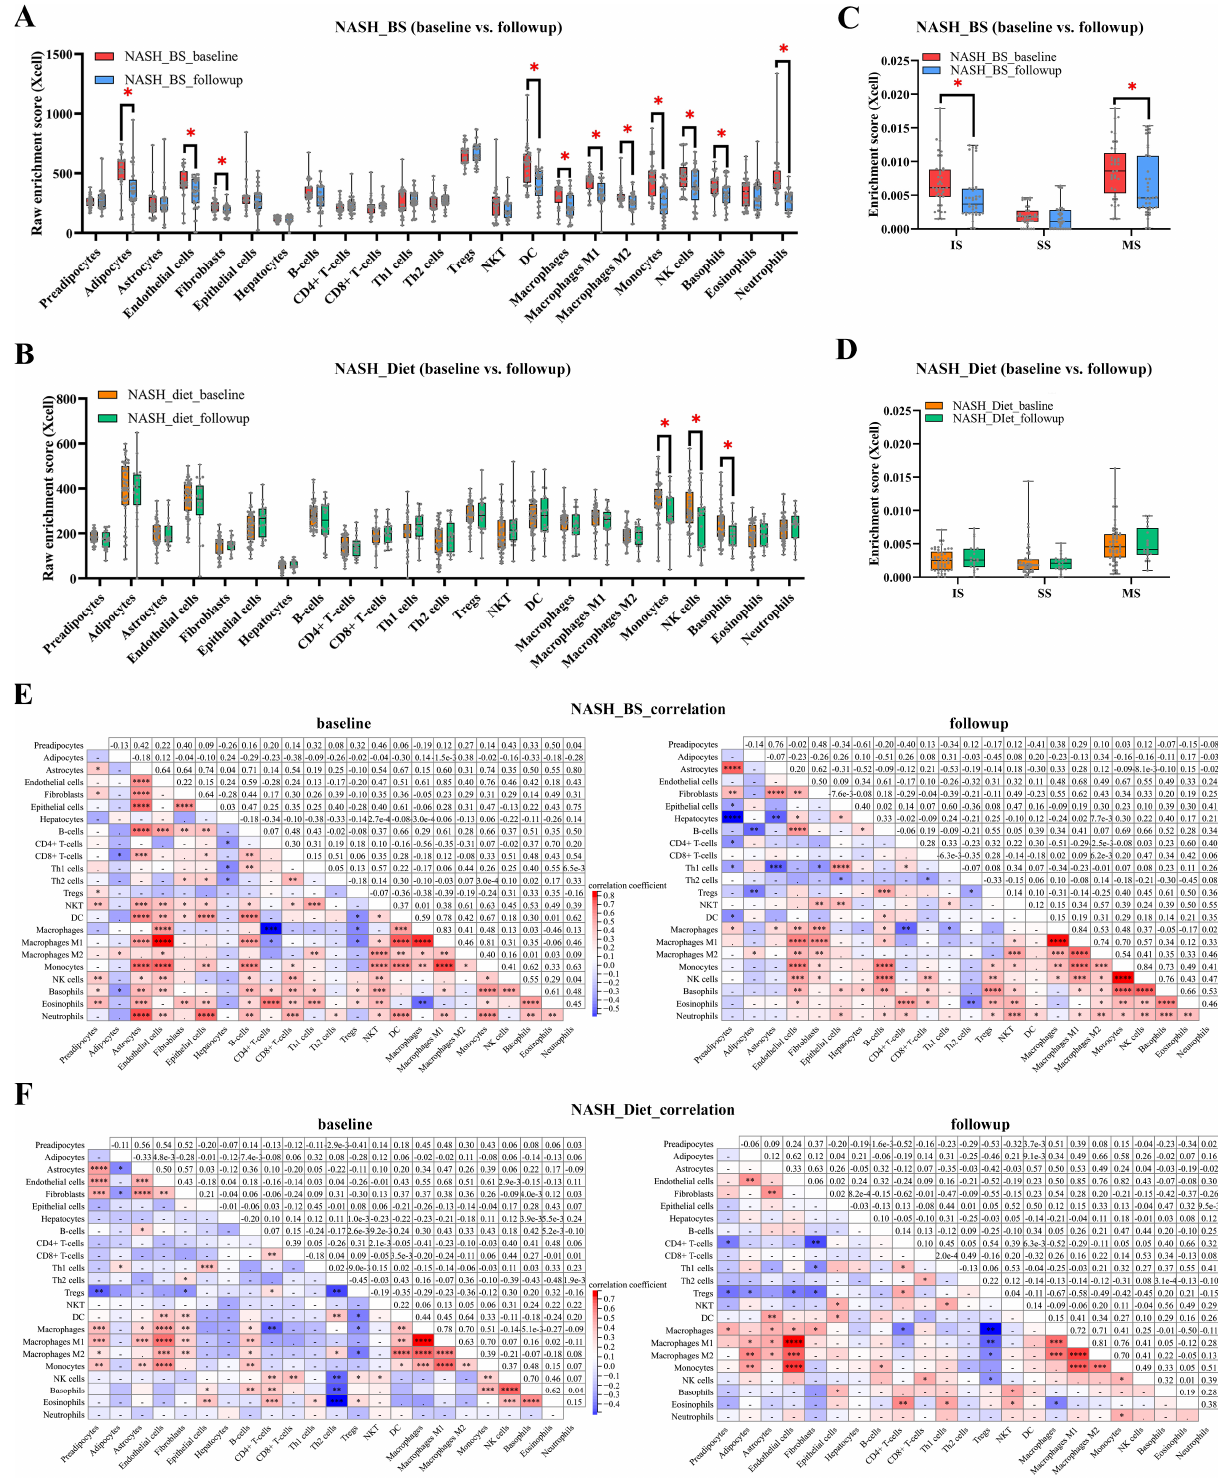
Figure 3. Cell type enrichment. Cell type enrichment levels of in total 7 parenchyma and 16 non- parenchyma cell types were displayed as NASH_BS ( A ) and NASH_Diet ( B ) subgroups. Immune scores were displayed as NASH_BS ( C ) and NASH_Diet ( D ) subgroups (*: p <0.05). Pearson’s correlation analyses were carried out mutually among 23 cell populations in NASH_BS ( E ) and NASH_Diet ( F ) subgroups (*: p <0.1, **: p <0.01, ***: p <0.001 , ****: p <0.0001).